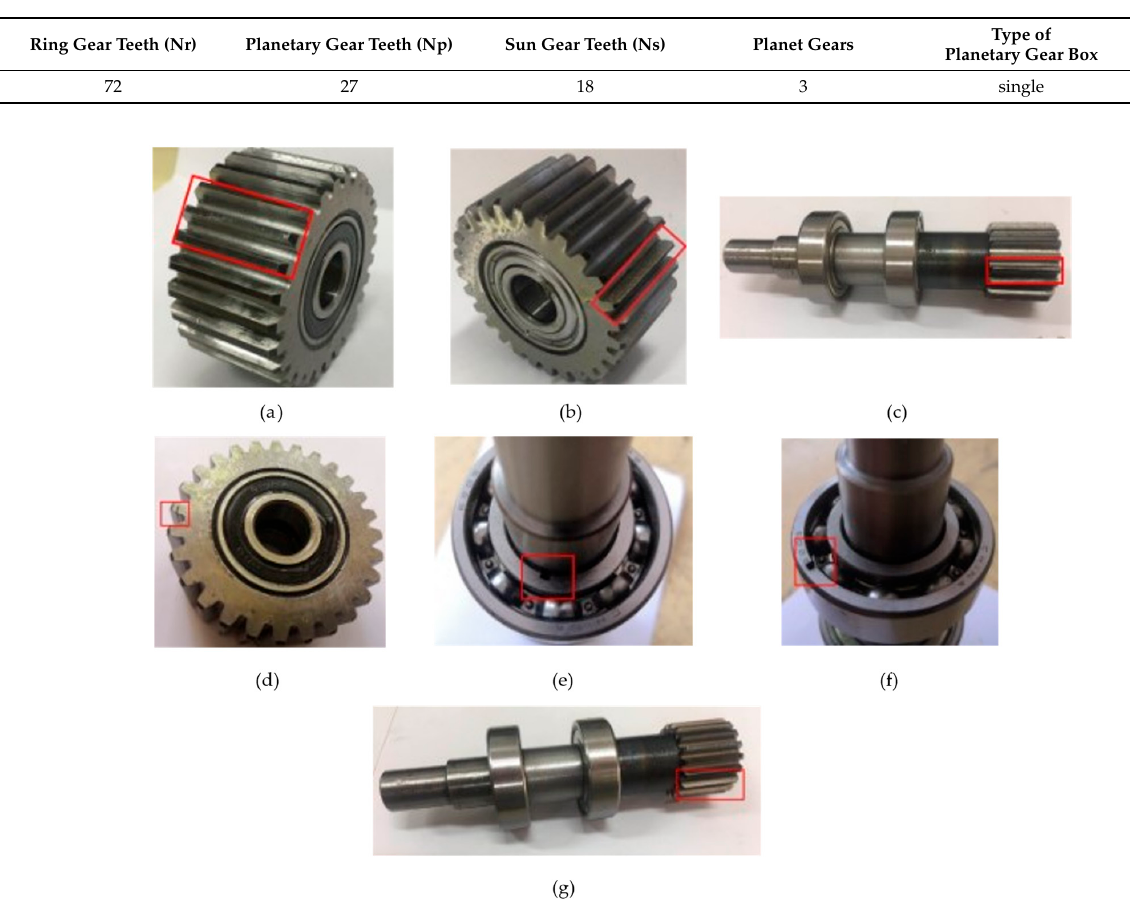
Figure 5. planetary gearbox experiment platform. Figure 5. Planetary gearbox experiment platform. Table 1. Basic parameters of the planetary gearbox. Table 1. Basic parameters of the planetary gearbox.